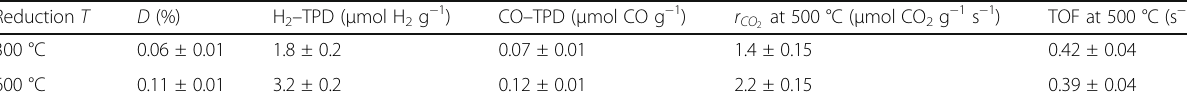
Table 1 Metal dispersion D , the amounts of released H 2 and CO per gram of the Ga 3 Ni 2 catalyst determined from TPD experiments, the reaction rate r CO , and the CO 2 turnover frequency (TOF) at 500 °C of the catalyst reduced at two different temperatures of 300 2 or 600 °C, respectively